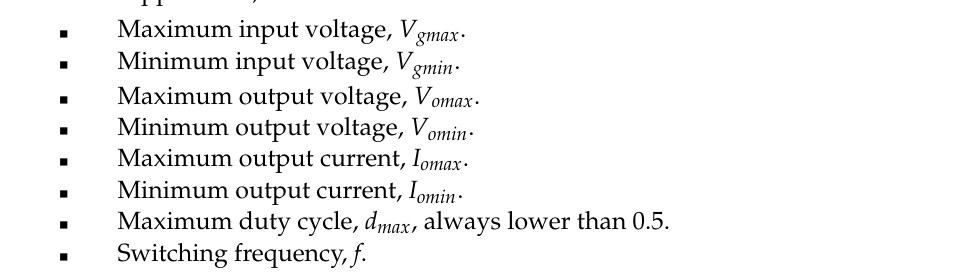
Table 1. Summary of the converter comparison.